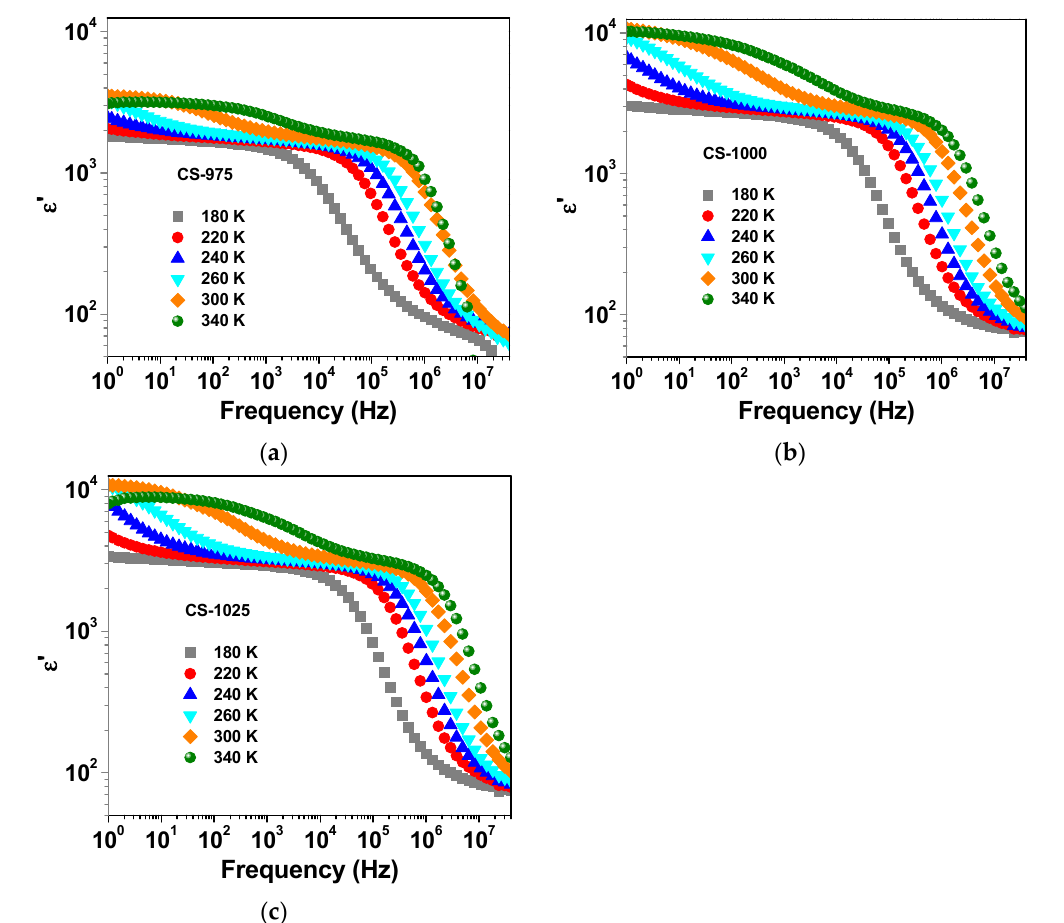
Figure 7. Frequency dependence of ε ’ at selected temperatures for LCTO ceramics; ( a ) CS-975, ( b ) CS-1000, and ( c ) CS-1025. The frequency dependence of ε (cid:48) and tan δ for LCTO samples is shown in Figure